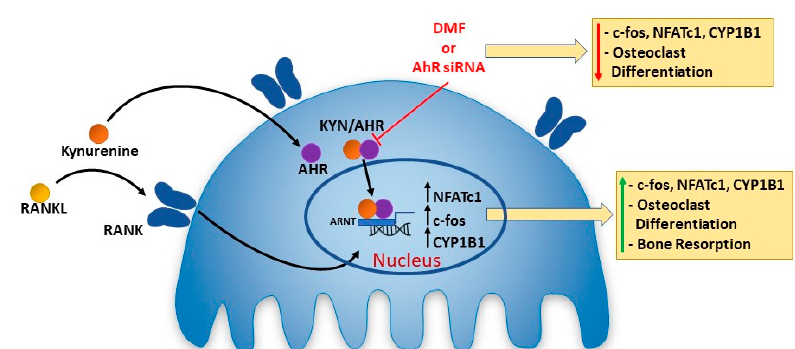
Figure 5. Kynurenine Induces Osteoclastogenesis Via the AhR Signaling Pathway. In the presence of RANKL, KYN induces Raw 264.7 cells to undergo osteoclastogenesis. This is mediated by KYN binding to AhR which translocates to the nucleus. Based on the literature the ligand bound to AhR forms a transcription factor complex with ARNT [12]. This complex binds to the Xenobiotic responsive elements in the promotor regions of target genes, which here include c-fos, NFATc1 and CYP1B1 [43,45–47]. The down-stream consequence is osteoclast differentiation and activation of osteoclast bone resorption. These effects can be blocked by pharmacologic inhibition of AhR with the DMF, or genetic inhibition with AhR siRNA. This suggests that inhibiting KYN levels, blocking KYN binding of AhR, or blocking KYN/AhR signaling may be potential therapeutic approaches to limit the role of osteoclast activity in age-associated bone loss or osteoporosis.